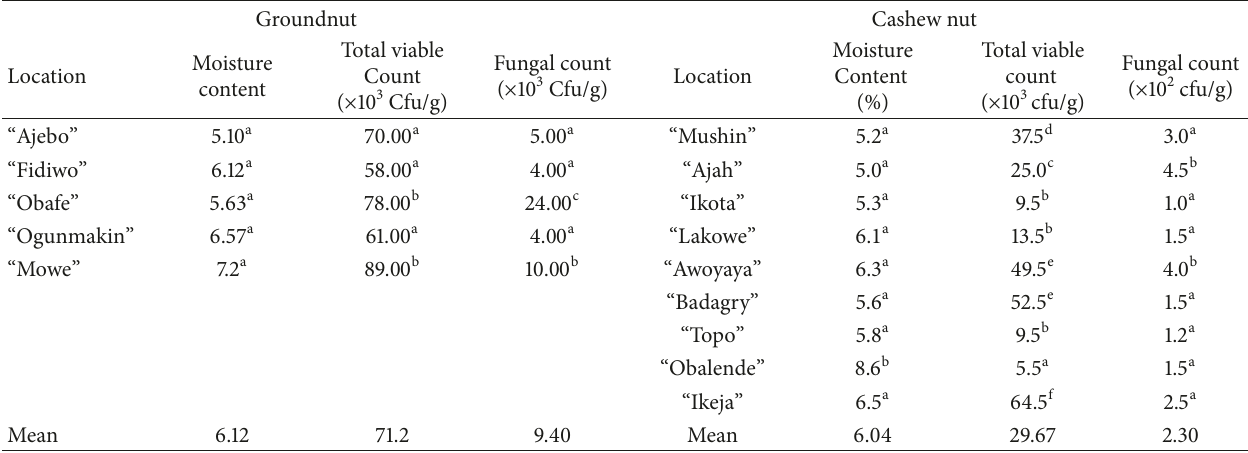
Table 1: Moisture content and colony counts of groundnuts and cashew nuts.